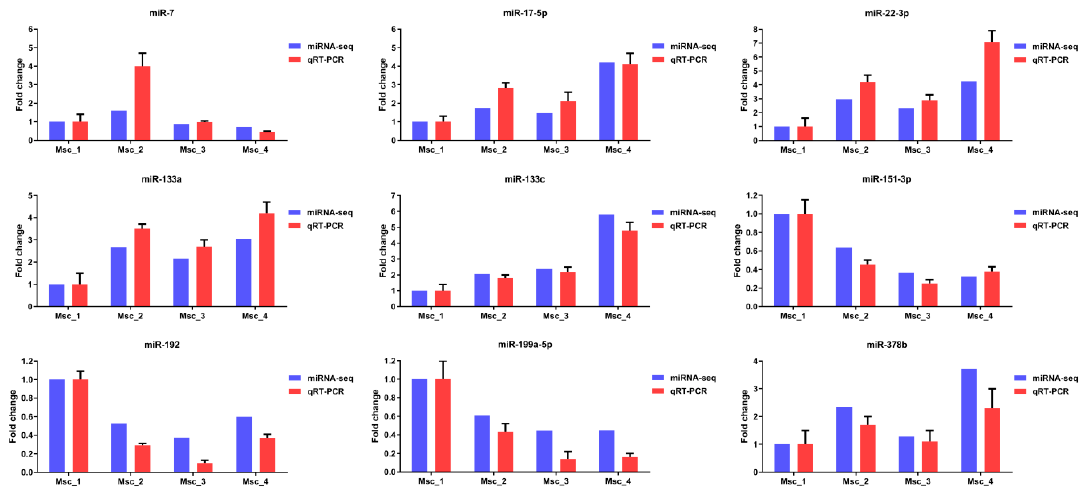
Figure 8. qRT-PCR validation of miRNA-seq data. The expression levels of nine di ff erentially expressed miRNAs (miR-133a, miR-133c, miR-17-5p, miR-22-3p, miR-378b, miR-192, miR-151-3p, miR-199a-5p, and miR-7) were normalized against U6 snRNA. The vertical axis indicates the normalized miRNAs expression level for each stage. For each miRNA, the expression level and sequencing abundance in Msc_1 were given as a negative control and set at